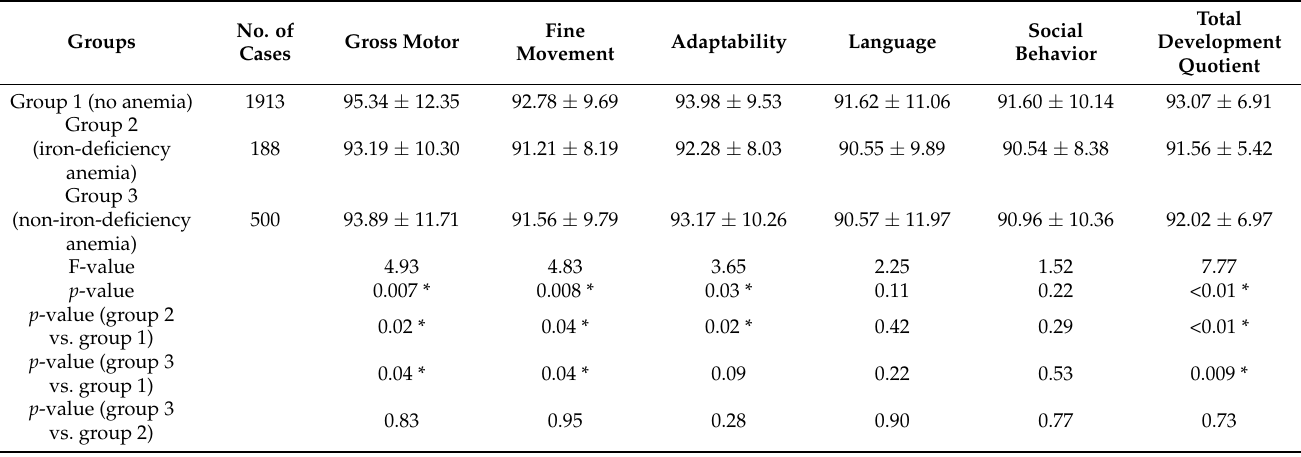
Table 2. Comparison of quotient scores of overall and specific domains of neurobehavioral development in children with different anemia